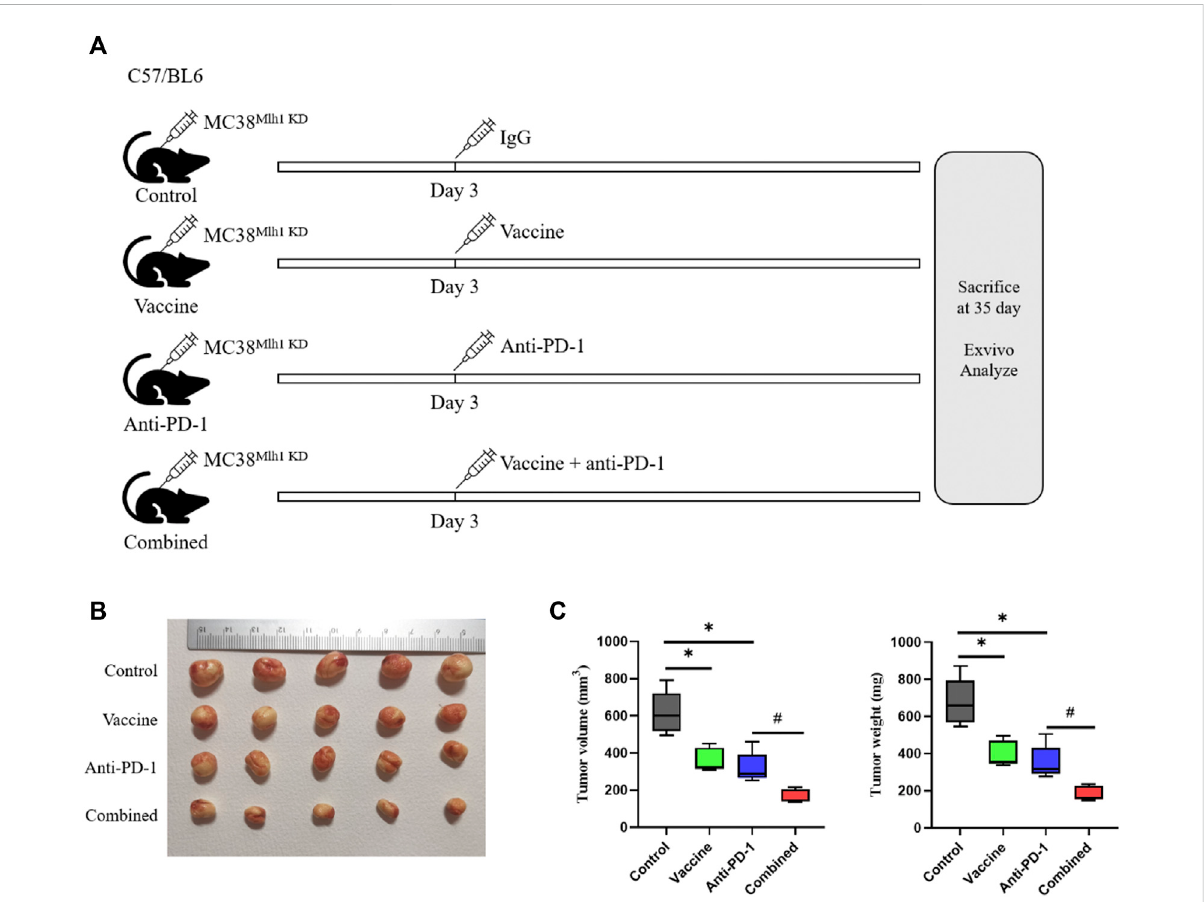
FIGURE 2 Combination therapy processed better anti-tumor effects than PD-1 blockage and vaccine alone. (A) Schema of tumor implantation and treatment (C57/BL6 mice were injected with MC38 Mlh1 KD cells in the right lower limb and divided into four groups with fi ve mice in each group). (B) Tumorsofeachgroupwerephotographedafterbeingstrippedfrommice. (C) Tumorsizeandweightweretestedafterremovalfrommice.Statistical signi fi cance was measured using Student ’ s t-test and one-way ANOVA. *, p < 0.05 vs. Control; # , p < 0.05 vs. Anti